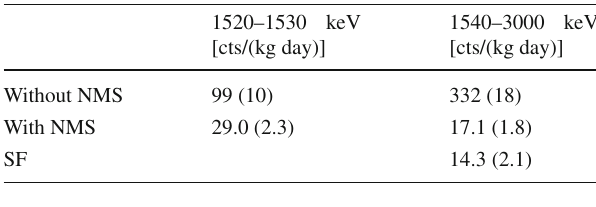
Fig. 11 Density diagram of the A/E parameter as a function of energy obtained in the measurements with the BEGe detector in LArGe with 228 Th source. Lines represent parameters of the PSD cuts obtained from this spectrum using events in the DEP and the Compton